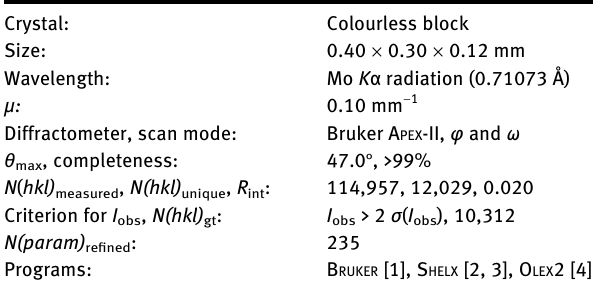
Table 1 contains crystallographic data and Table 2 contains the list of the atoms including atomic coordinates and displacement parameters.